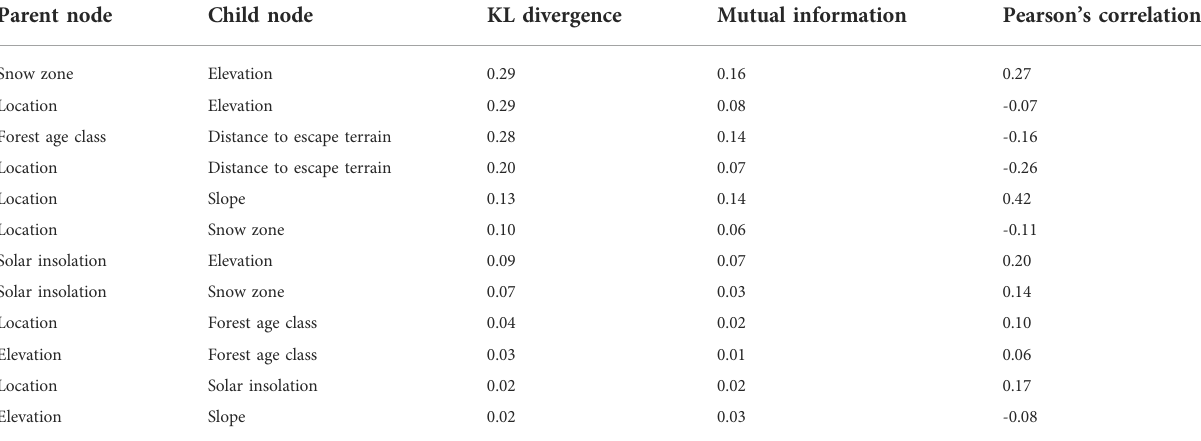
TABLE 1 Relationships among nodes in the mountain goat winter habitat suitability